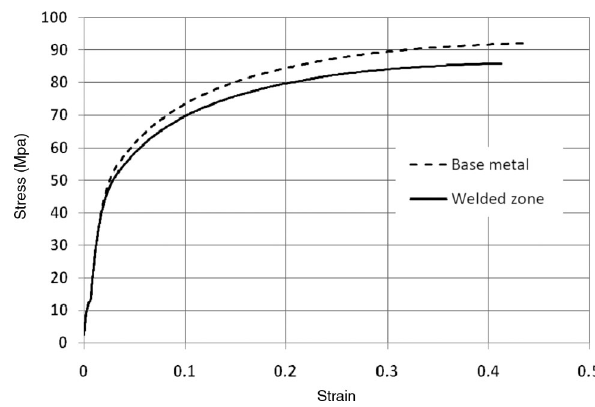
Figure 4: Stress-strain behaviour of the base and friction stir welded 19501 aluminium alloy.